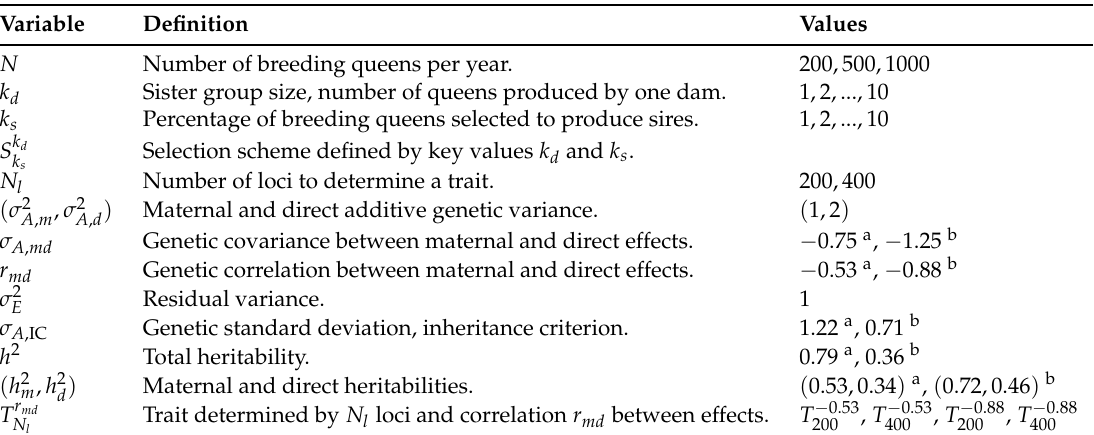
Table 1. Variable